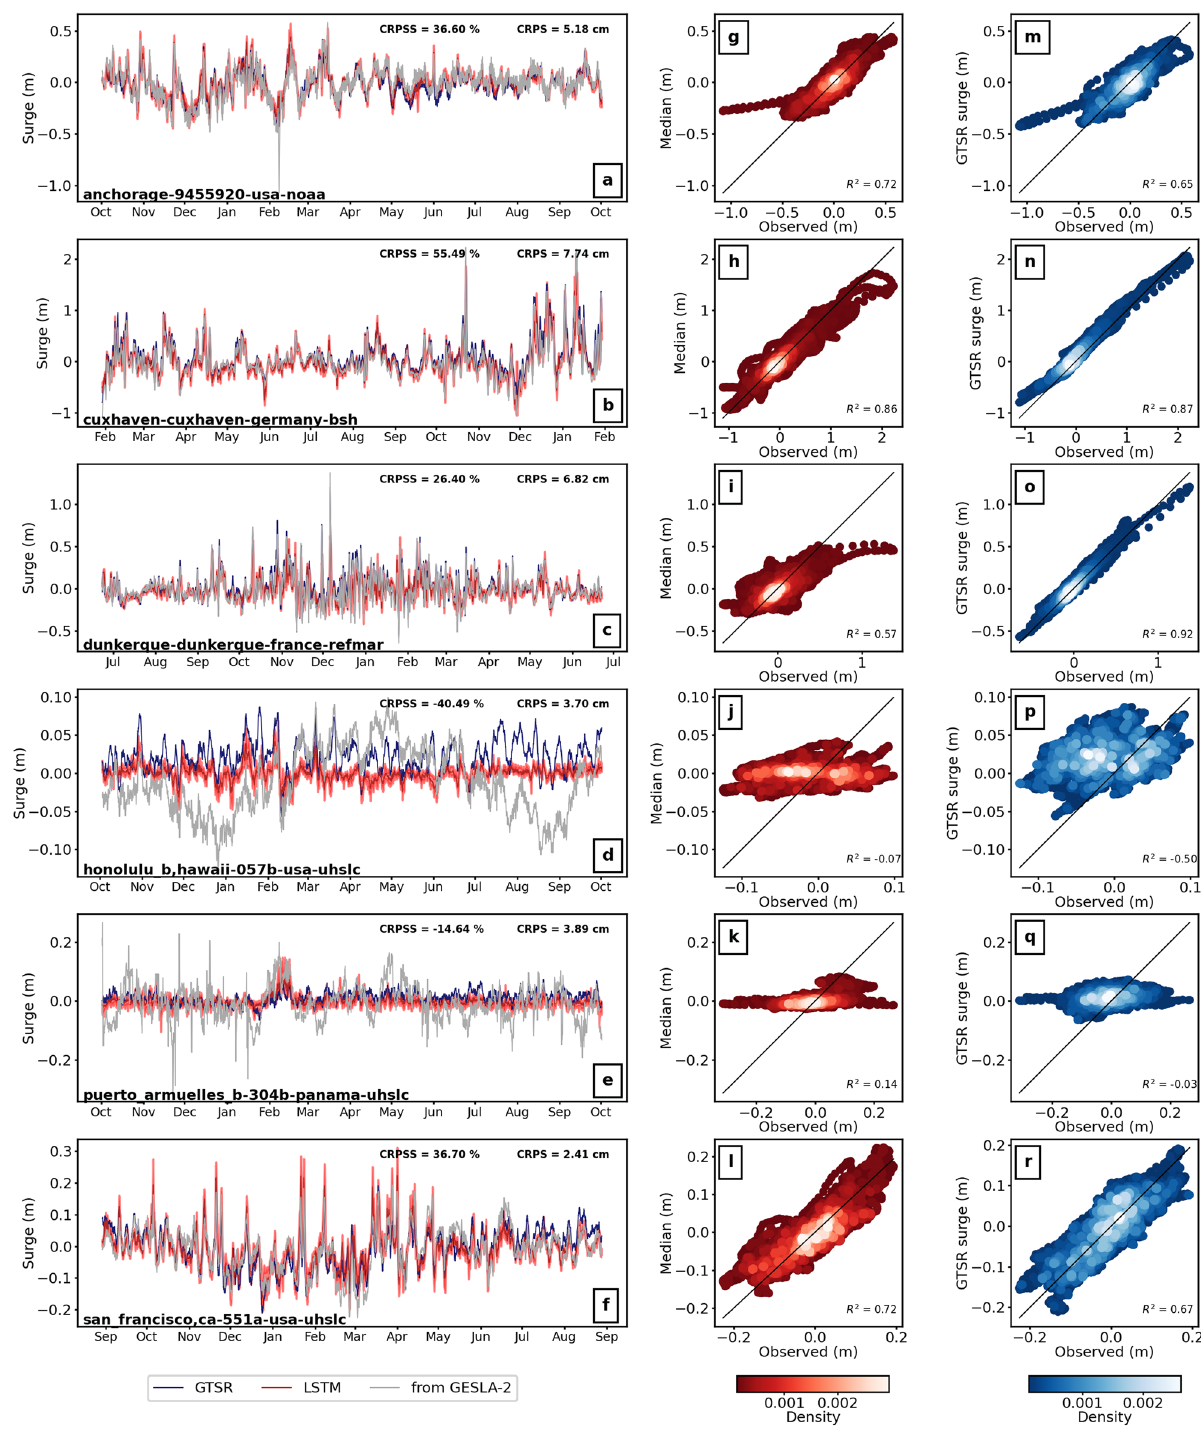
Figure 5. ( a–f ) Hourly surge predictions for the testing year from the LSTM model, observed and surge from the Global Tide and Surge Model forced with ERA5 and ( g – l ) scatter plot of the median from the predicted ensemble with the observed surge and ( m – r ) with the GTSM